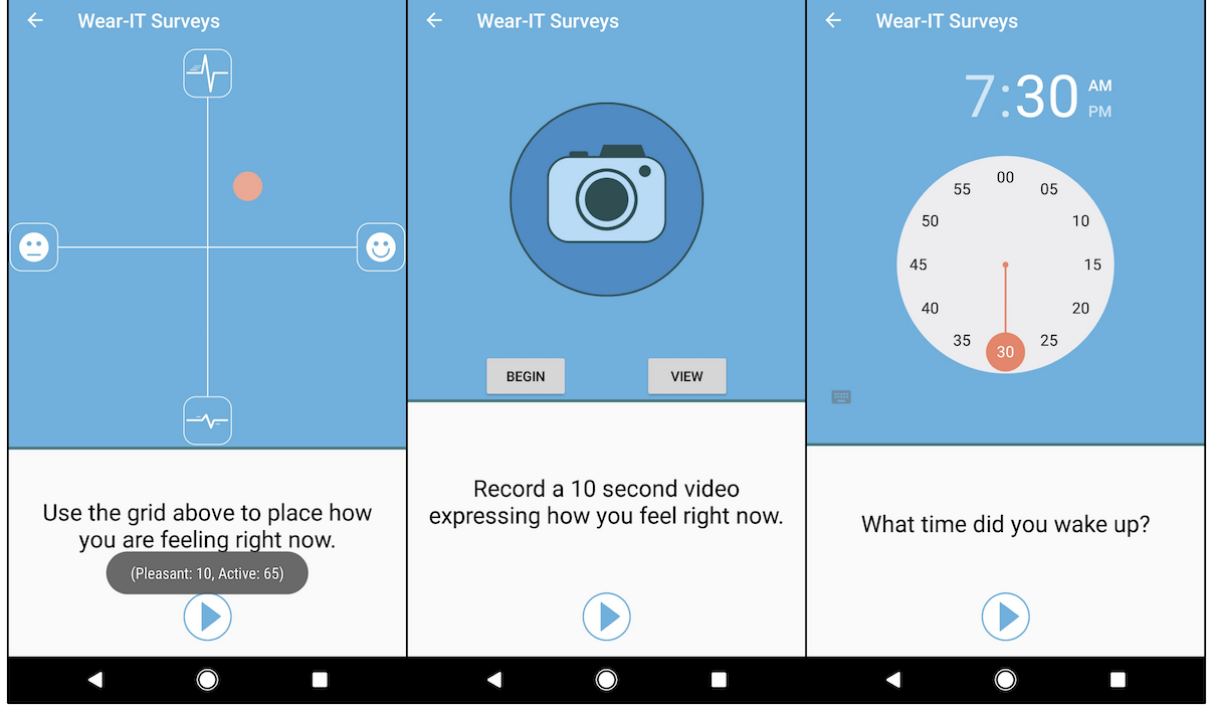
Web Server and App